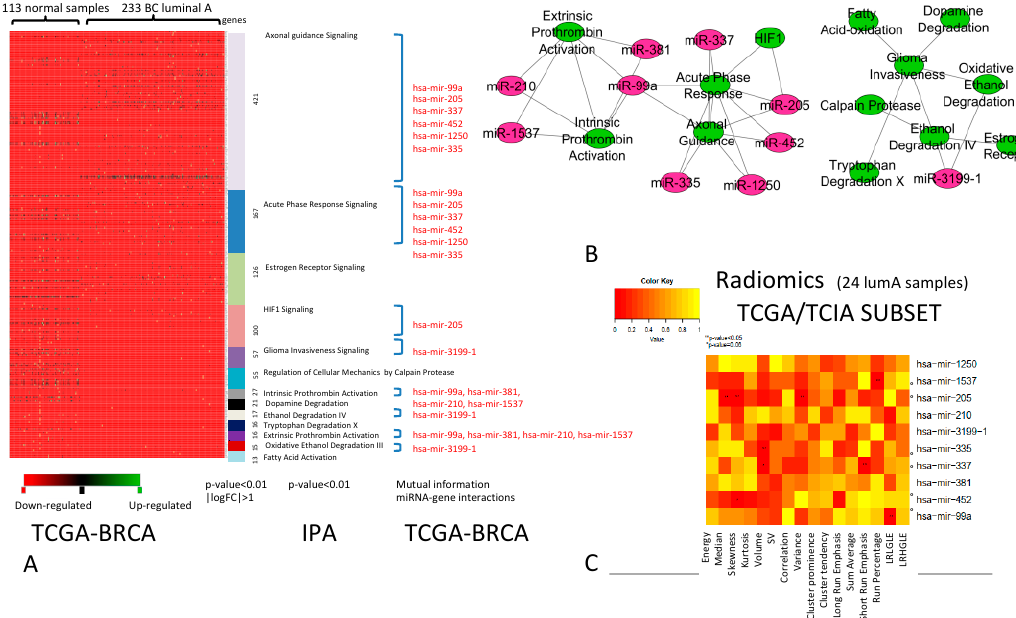
Figure 1. Breast cancer (BC) Luminal A. ( A ) The pathways able to classify Luminal A vs. normal samples ( p -value < 0.01, |logFoldChange (FC)| > 1). For each pathway (in different colours), miRNAs (indicated in red) able to regulate differentially expressed genes (DEGs) are indicated. ( B ) Relationships between pathways and miRNAs (green nodes, pathways; purple nodes, miRNAs). ( C ) Heatmap of the correlation between imaging features and miRNAs. The color intensity in the figure shows the corresponding p-value; yellow cells indicate greater statistical significance.